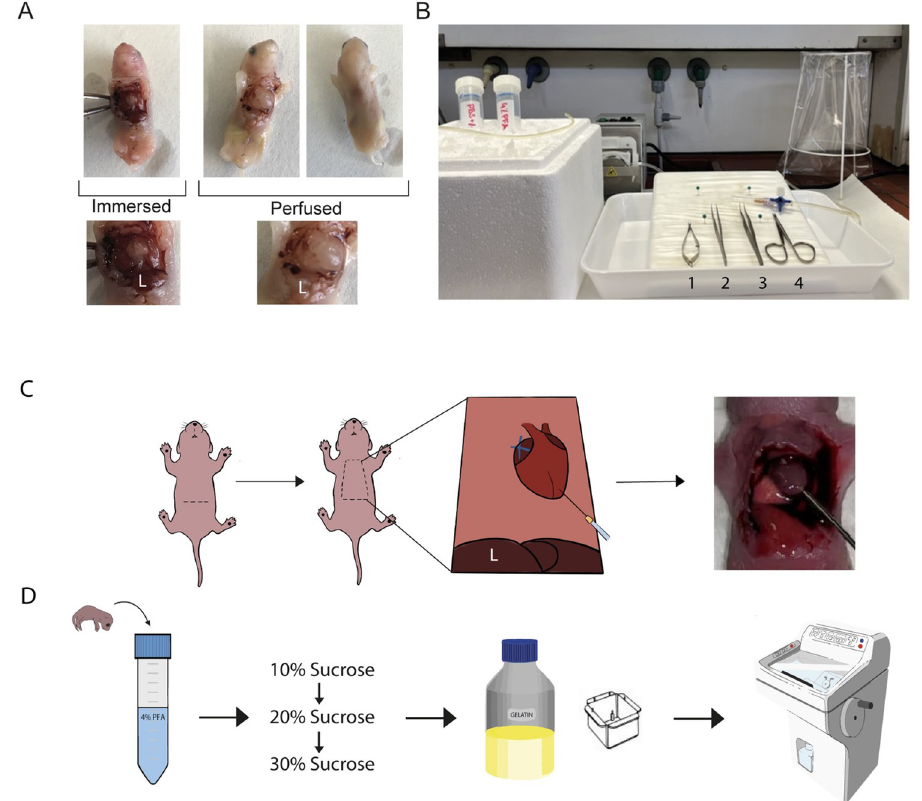
Fig 1. Schematic view of the protocol. a. Comparison between fixation by immersion and trans-cardiac perfusion in neonatal mice. The liver (L) is shown in detail. b. Set-up for the perfusion with the materials needed (1. Microscissors, 2. Straight Forceps, 3. Curved Forceps, 4. Small Scissors). c. Scheme of the surgical procedure during the perfusion. d. Scheme of the post-fixation procedure to prepare the tissue for